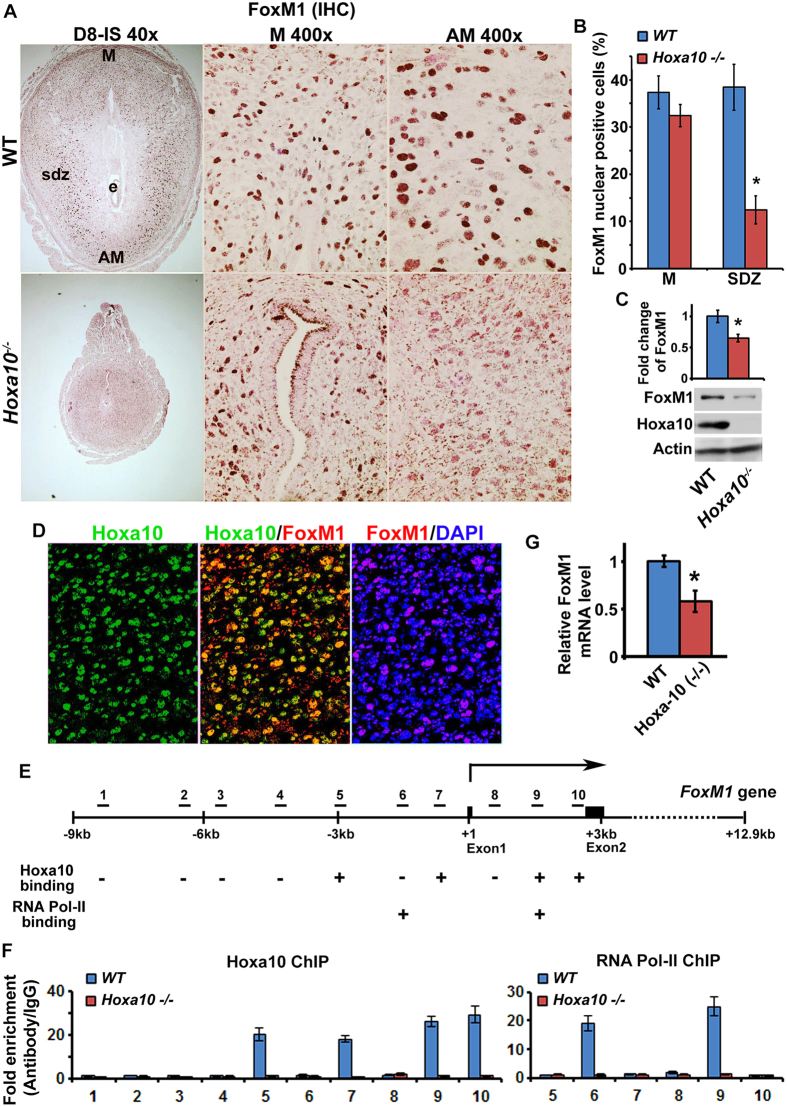
Hoxa10 regulates FoxM1 in SDZ cells via a transcriptional mechanism.(A) Immunohistochemical analysis of FoxM1 at IS on D8 between wild-type (WT) and Hoxa10−/− mice. High magnification pictures (at 400X) are shown for mesometrial (M) and antimesometrial (AM) locations. Note: Data show reduced expression of FoxM1 at the SDZ location (lateral or antimesometrial) in Hoxa10−/− compared to that of WT. e, embryo; sdz, secondary decidual zone; M, mesometrial; AM, antimesometrial. (B) Quantitation of nuclear FoxM1 positive cells in M and SDZ locations at IS on D8 between WT and Hoxa10 null mice. (C) Western blot analyses of FoxM1, Hoxa10, and actin at IS on D8 between WT and Hoxa10 null mice. Quantitative analysis of FoxM1 expression shows in the Bar plot. (D) Dual immunofluorescence analysis of Hoxa10 (green) and FoxM1 (red) at the SDZ on D8-IS. DAPI was used for nuclear staining. (E) Diagrammatic illustration of putative Hoxa10 binding regions (1–10) in 5’-flanking, exon 1, and intron 1 of FoxM1 gene. “+” or “–” indicates actual detection of positive or negative binding of Hoxa10 or RNA Pol-II. (F) Quantitative ChIP-PCR analysis of Hoxa10 or RNA Pol II binding for WT and Hoxa10 null in deciduoma tissues on D7, as described in Materials and Methods. (G) Analysis of FoxM1 expression in deciduoma tissues on D7 by quantitative RT-PCR between WT and Hoxa10 null mice, after normalization with Rpl7, a housekeeping gene.